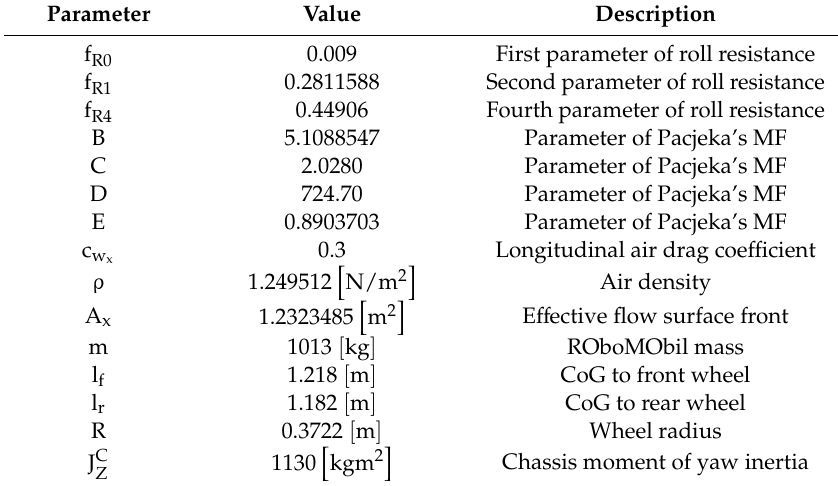
Table A1. ROMO’s ROboMObil’s—(German Aerospace Center’s (DLR’s) robotic electric vehicle) extended single track model (ESTM) optimized